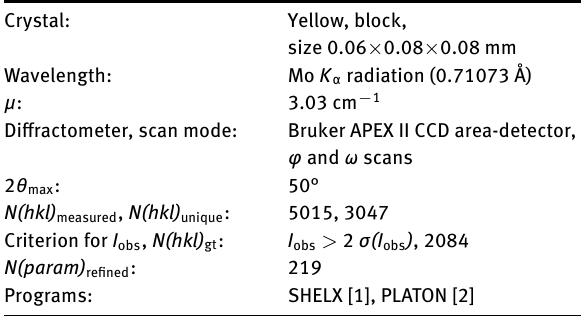
Table 2: Fractional atomic coordinates and isotropic or